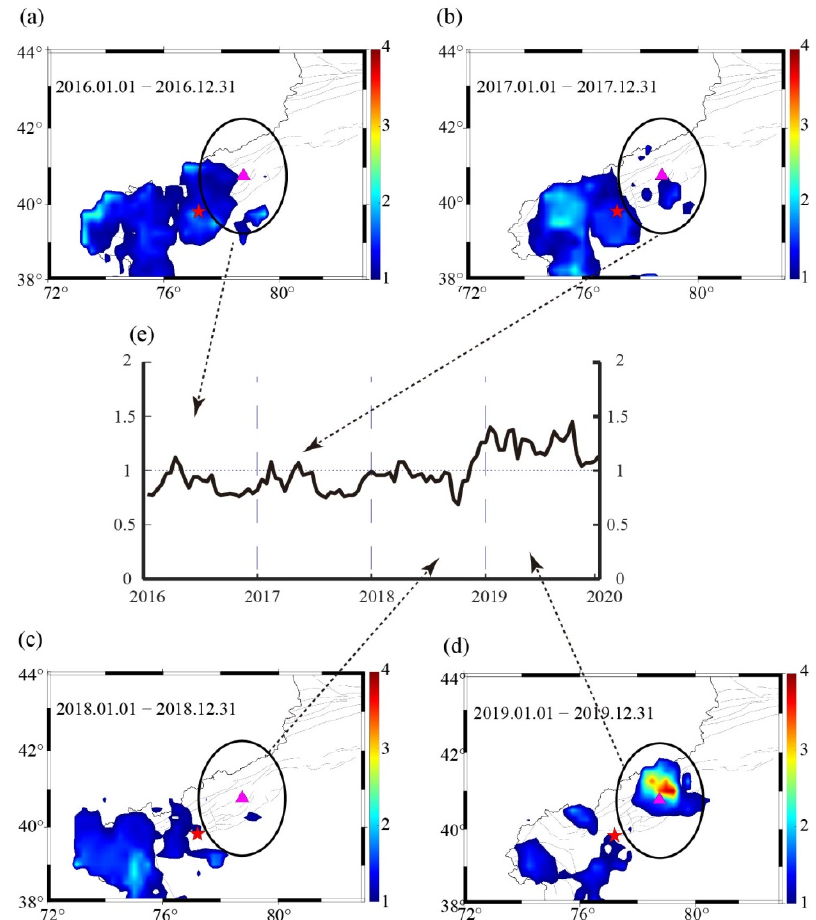
Figure 7. Spatiotemporal evolution of the load/unload response ratio (LURR) in the Atushi–Kalpin Thrust Zone from 1 January 2016 to 31 December 2019 ( a – d ); ( e ) is the temporal curve of LURR mean value within 150 km around Kalpin observatory. The red star indicates the epicenter of the Jiashi Mw 6.0 earthquake and the pink triangle indicates the location of the Kalpin Apparent Resistivity Observatory.